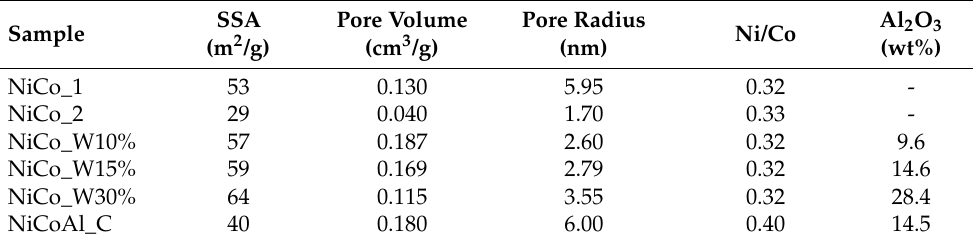
Table 1. SSA, pore volume, pore radius, Ni/Co ratio, and Al 2 O 3 content about the catalytic powder